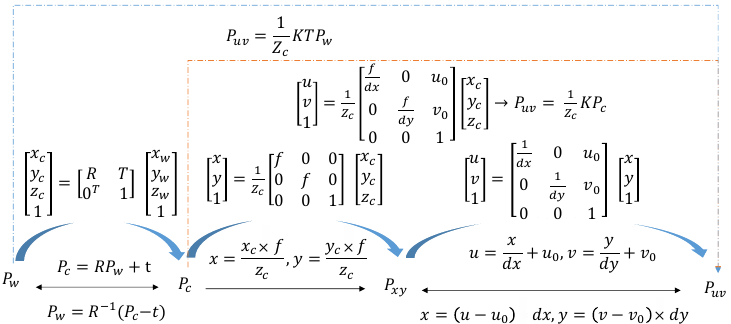
Figure 3. Coordinate conversion formula between different coordinate Figure 4.5.Coordinate conversion formula between different coordinate systems